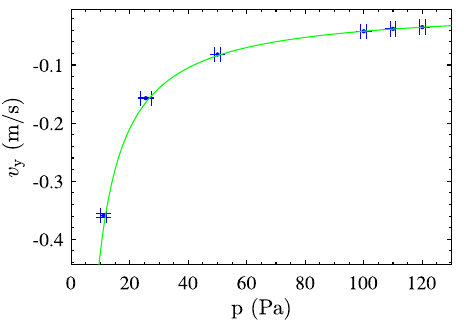
Fig. 7 Vertical velocity of single microparticles as function of pressure. Measured vertical velocity of single microparticles as a function of the pressure together with the expected vertical velocity based on Eq. (1) in the free molecular fl ow regime for δ = 1.442 and ρ p = 1.61 × 10 3 kg m − 3 (green line). The error bar in the pressure is determined by experimental limitations, while the error bar in the vertical velocity is represented by the standard deviation of the mean of the singlet velocity